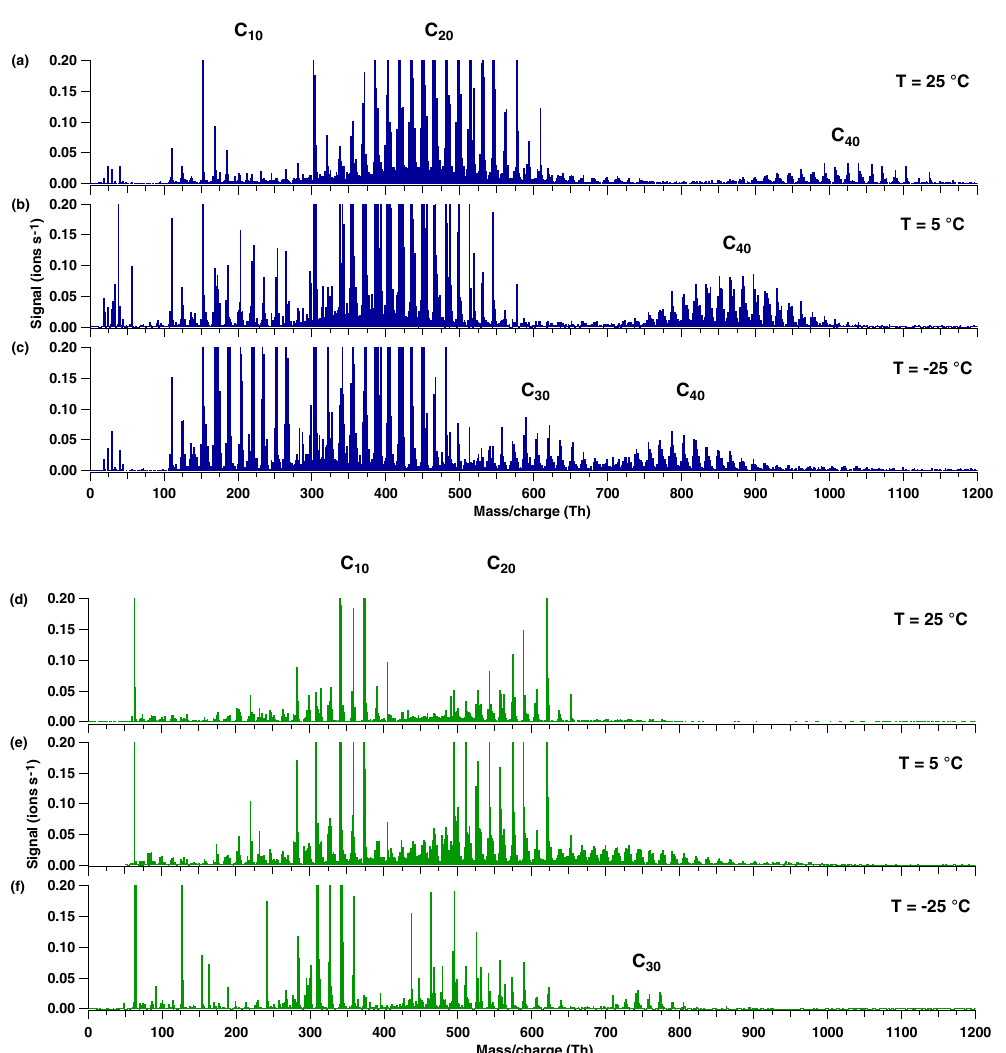
Figure 3. Positive (a–c) and negative (d–f) mass spectra during pure biogenic nucleation induced by ozonolysis of α -pinene at three tempera- tures: 25 ◦ C (a, d) , 5 ◦ C (b, e) and − 25 ◦ C (c, f) . A progressive shift towards a lower oxygen content and lower masses is observed in all bands